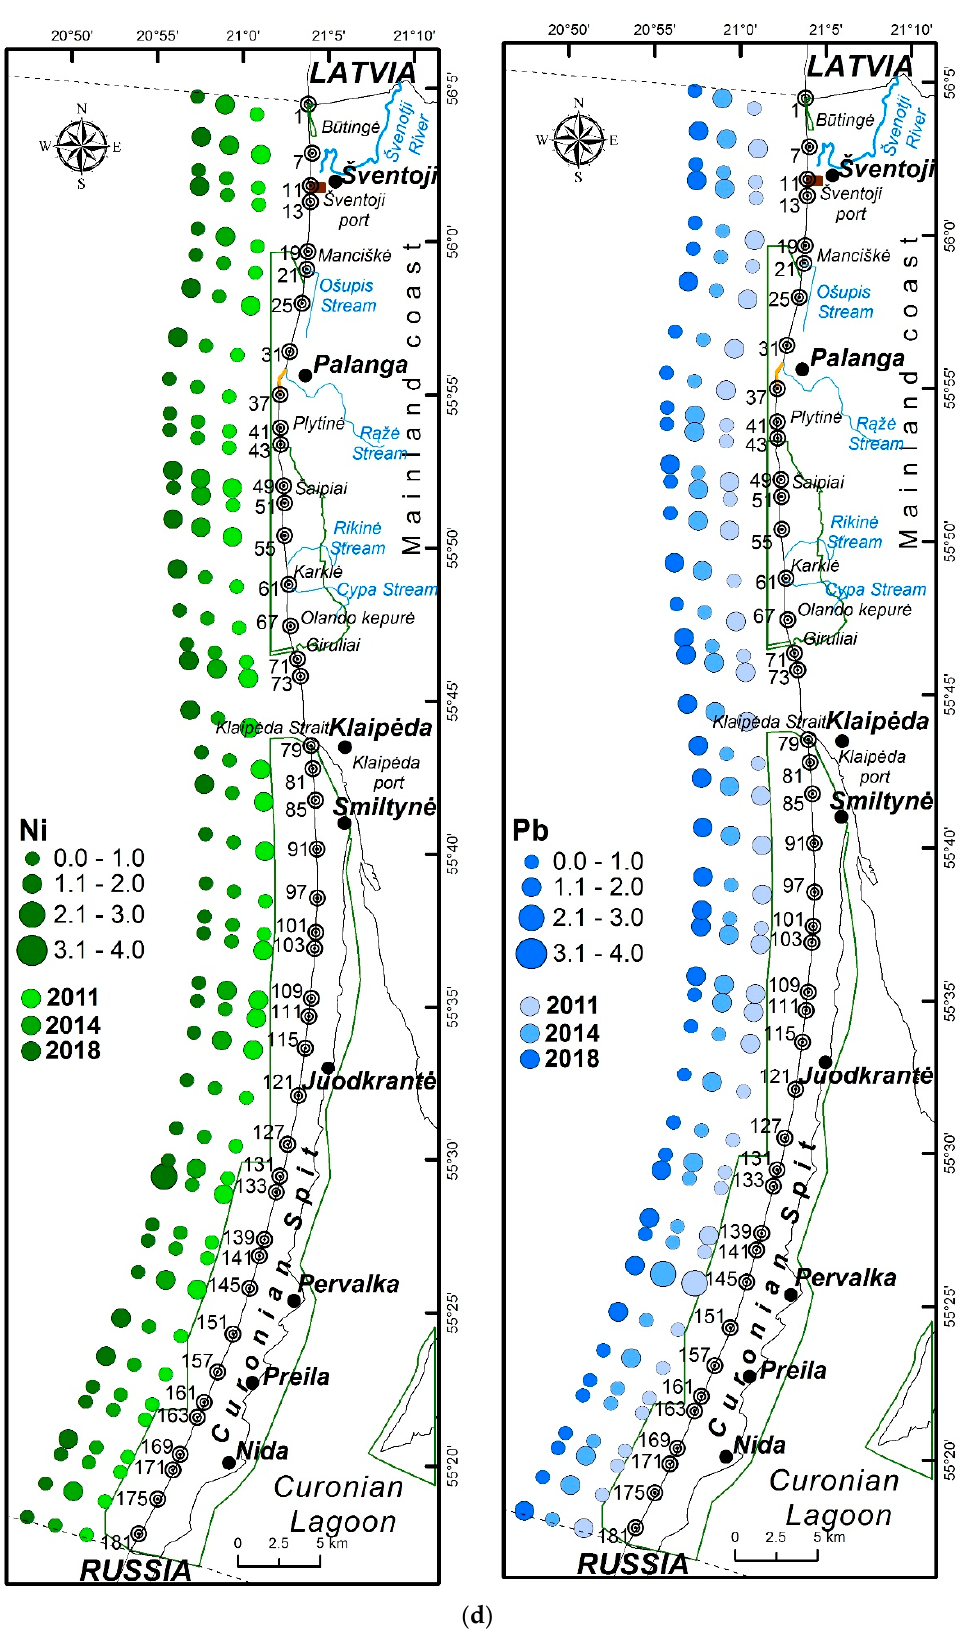
Figure 5. The distribution of concentration ratio ( K k ) of ( a ) Cu and Mn, ( b ) Cr and Zn, ( c ) As and Co, and ( d ) Ni and Pb along the coast of the south-eastern Baltic Sea coast (Lithuania).